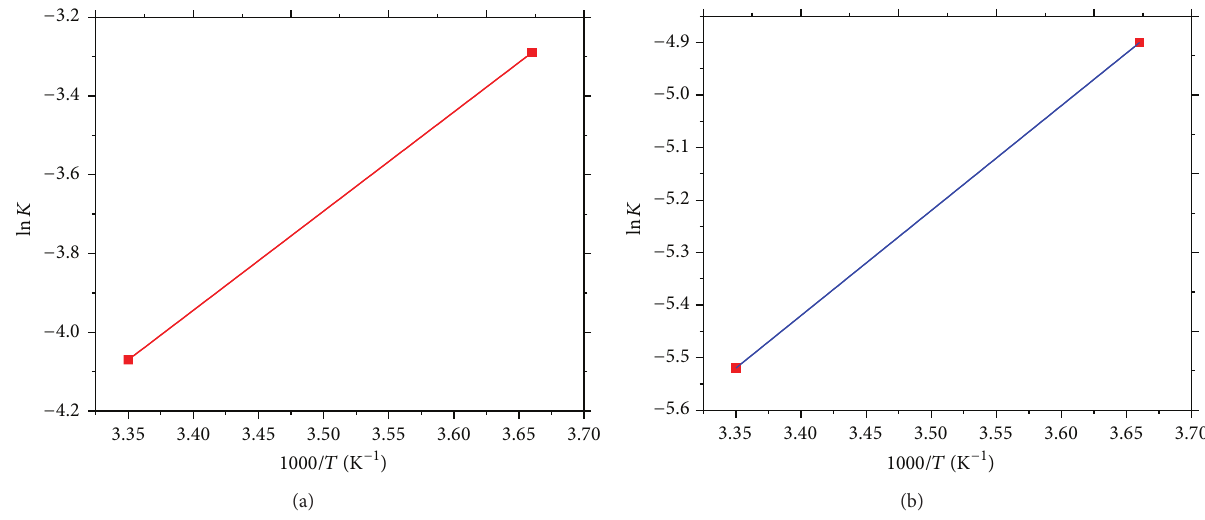
Figure 8: Van’t Hoff plots of CO 2 (red) and CH 4